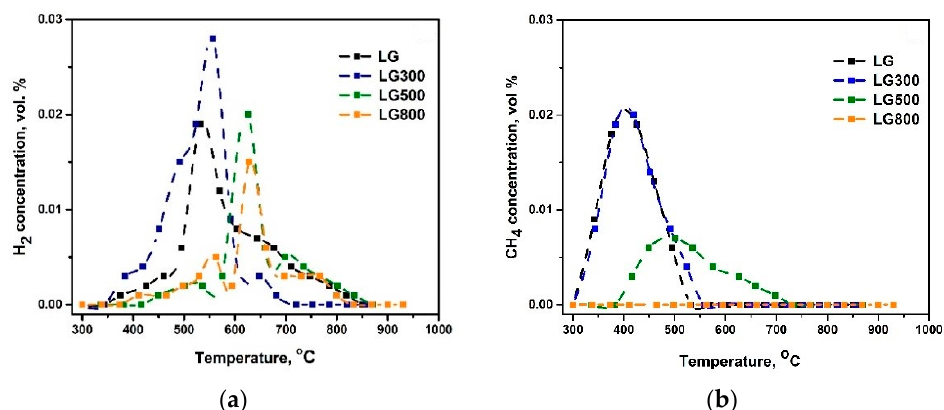
Figure 9. H 2 ( a ) and CH 4 ( b ) evolution profiles for raw lignite and chars during non-isothermal CO 2 gasification. Fuel: 100 mg, Flowrate: 30 cm 3 /min. gasification. Fuel: 100 mg, Flowrate: 30 cm 3